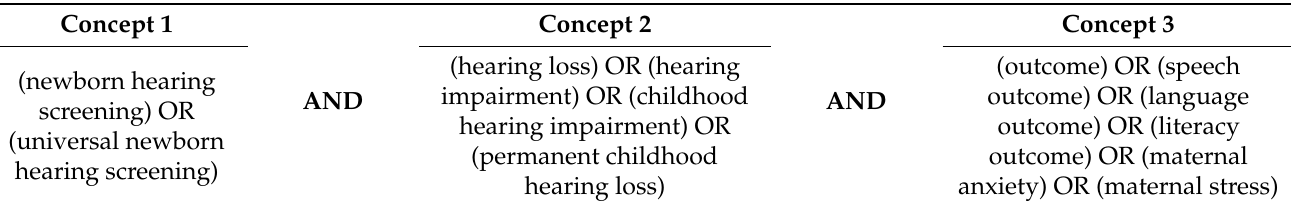
Table 1. Search strategy